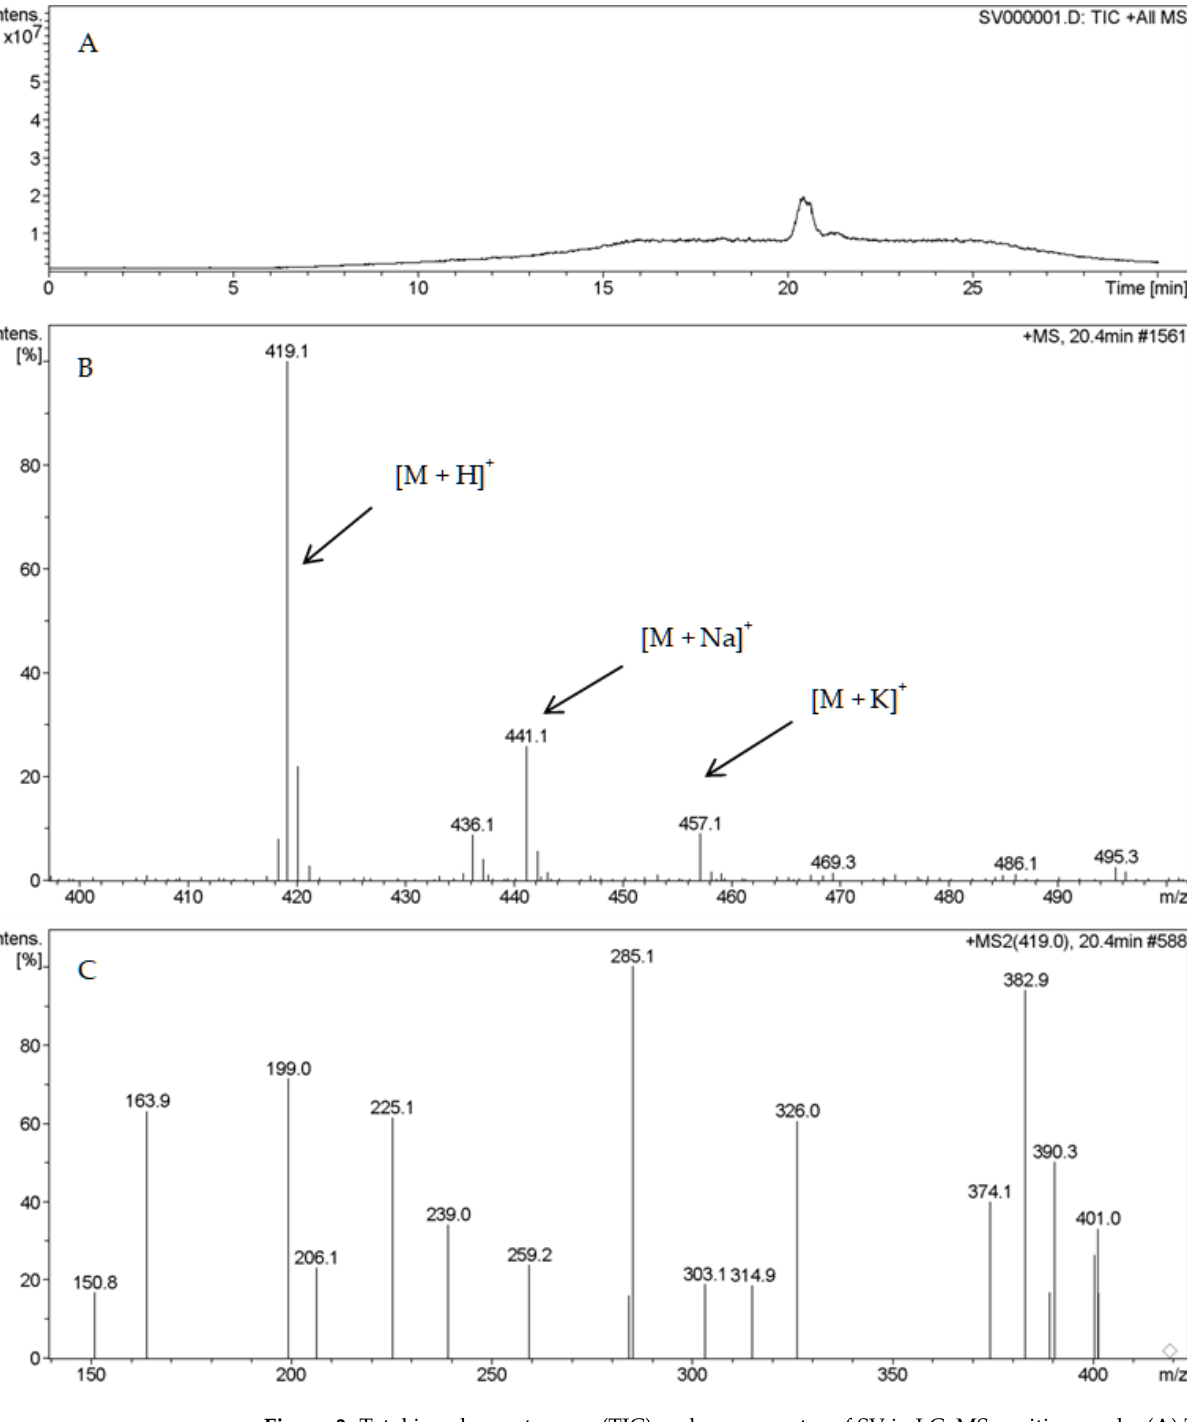
Figure 3. Total ion chromatogram (TIC) and mass spectra of SV in LC–MS positive mode: ( A ) TIC of SV; ( B ) Mass spectrum of SV; and ( C ) MS 2 spectrum of SV.